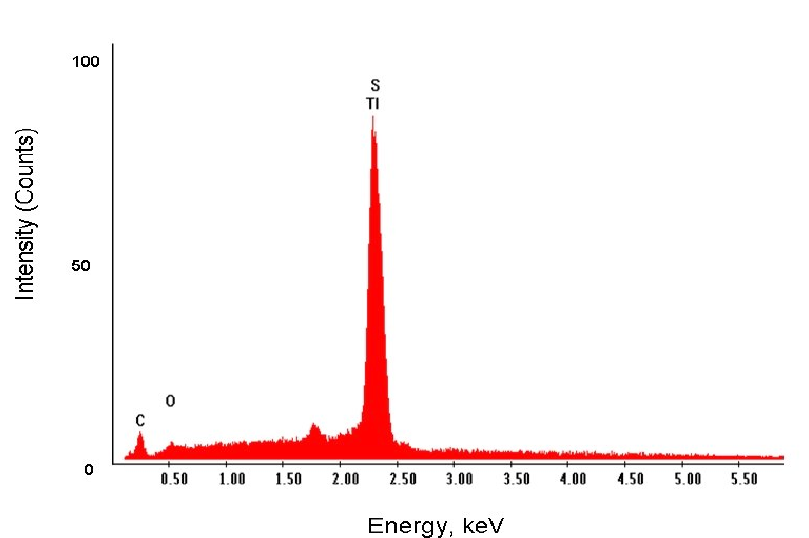
Figure 4. EDX spectrum of the deposited Tl